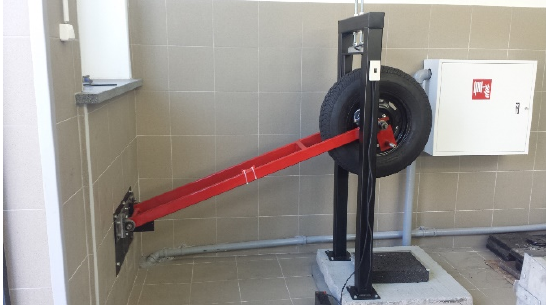
Figure 5. Facility to test dissipation of energy in tire by oscillation method.